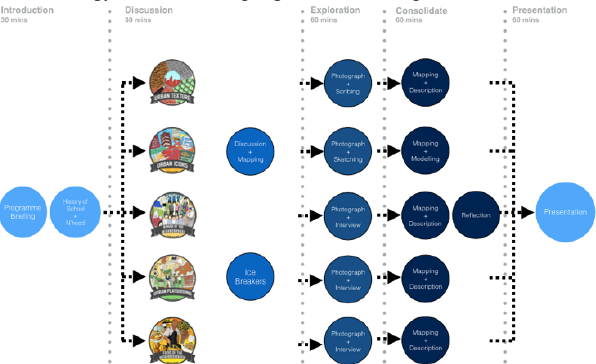
Figure 2. School Engagement